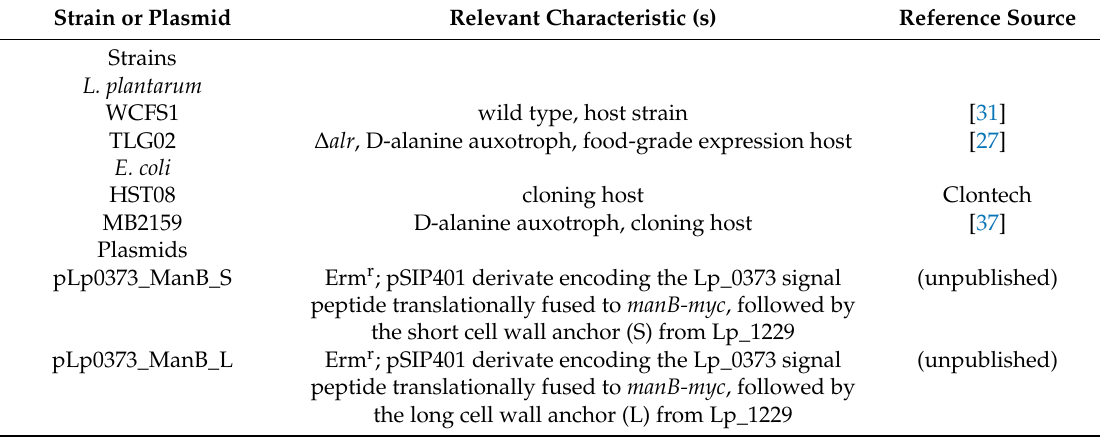
Table 1. Strains and plasmids used in this